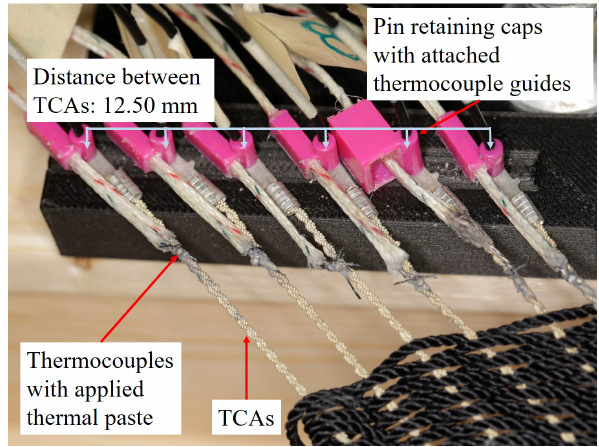
Figure 2. Thermocouples after having been attached to the TCAs, with thermal paste applied.